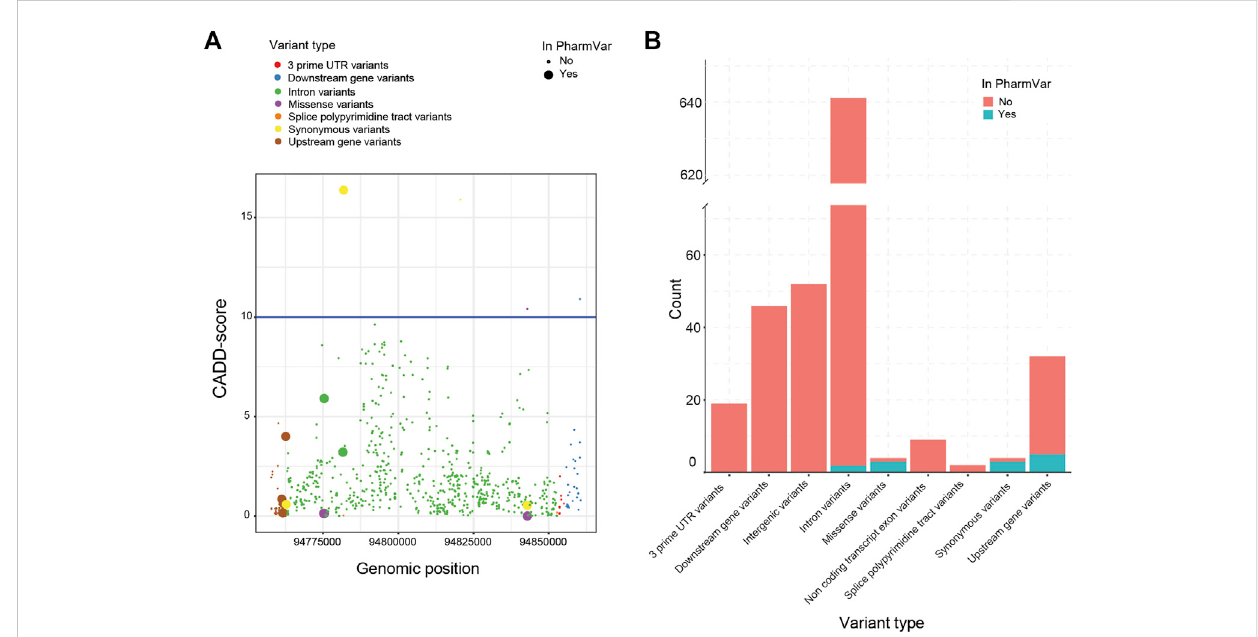
FIGURE 2 Variant impact analysis for identi fi ed CYP2C19 variants. The variant impact analysis by VEP, resulted in Combined Annotation Dependent Depletion (CADD) scores ( A, left ) and predicted variant effect ( B, right ), for every identi fi ed variant of CYP2C19 in our cohort. (A) Available CADD-scores of all detected CYP2C19 variants. The blue line marks the cut-off CADD score of 10. (B) Predicted variant effect of all detected CYP2C19 variants. Clinical variants are based on the PharmVar